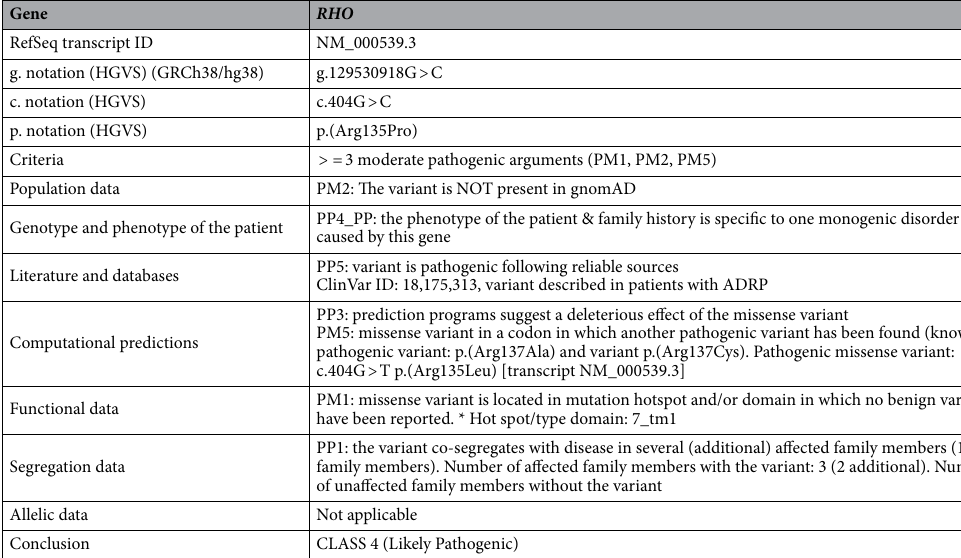
Table 1. Variant classification using ACMG 2015 and ACGS guidelines. PM, pathogenic moderate; PP, pathogenic supporting; PS, pathogenic